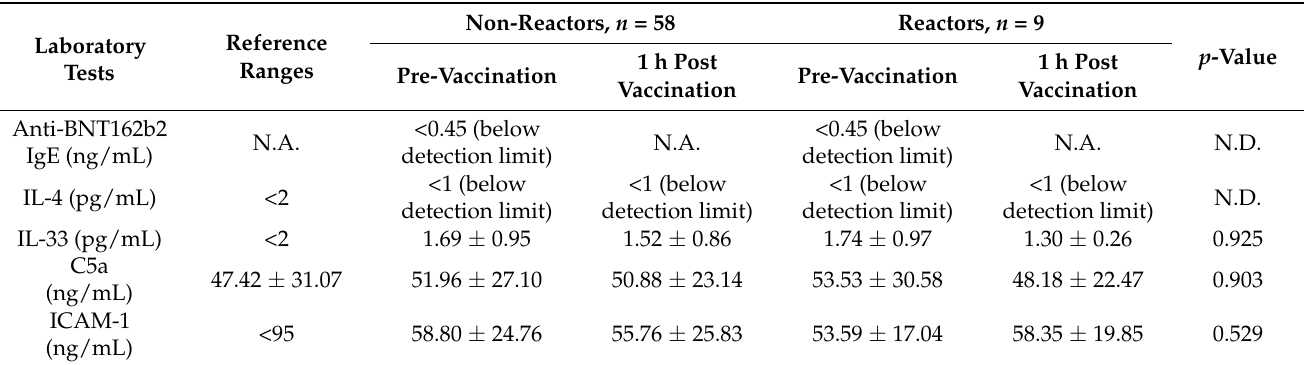
Table 3. Descriptive statistics of anti-Pfizer BNT162b2 IgE, cytokines and ICAM-1 for endothelial activation pre and post BNT162b2